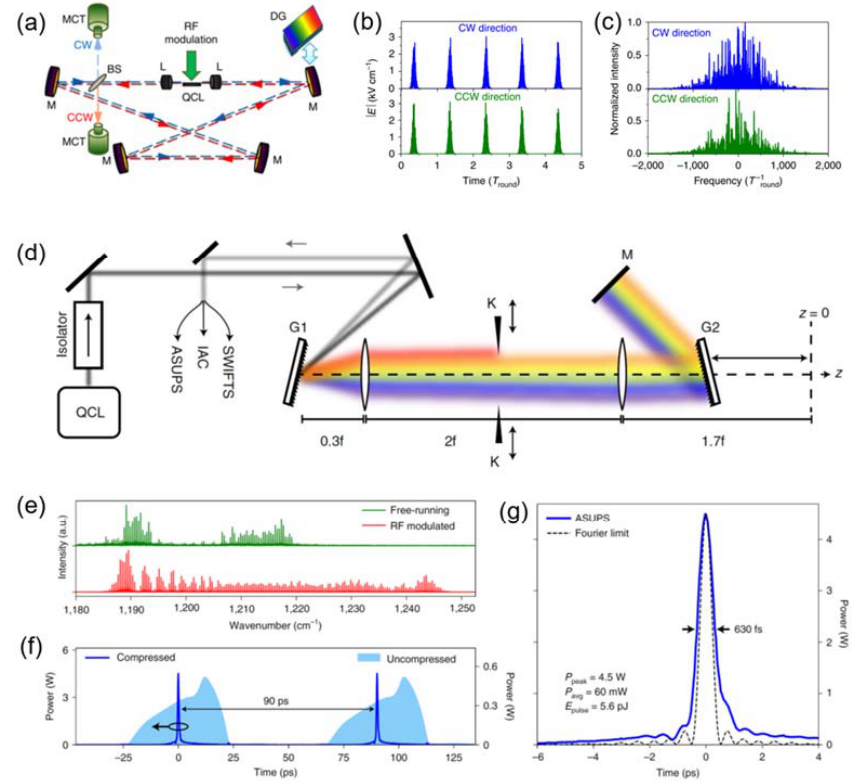
Figure 10. ( a ) Optical set-up of free-space external ring cavity quantum cascade laser. BS: beam splitter; CCW: counter-clockwise direction; CW: clockwise direction; DG: diffraction grating; L: aspheric lenses; M: mirrors; MCT: detector. ( b ) Absolute values of the electric fields and ( c ) their spectra for a sinusoidal modulation of bias with the modulation period equal to 1.01 T round . ( d ) The experimental setup for pulse compressing using diffraction grating compressor. ( e ) Free-running and RF-modulated optical spectra of mid-infrared QCL emission. ( f ) The intensity profile of the QCL before and after pulse compression. ( g ) The shortest pulse obtained with a pulse length of 630 fs with a peak power of 4.5 W. (Figure ( a–c ) from Ref [24], licensed under a Creative Commons Attribution (CC BY) license . Figure ( d–g ) from Ref [27], licensed under a Creative Commons Attribution (CC BY) license).